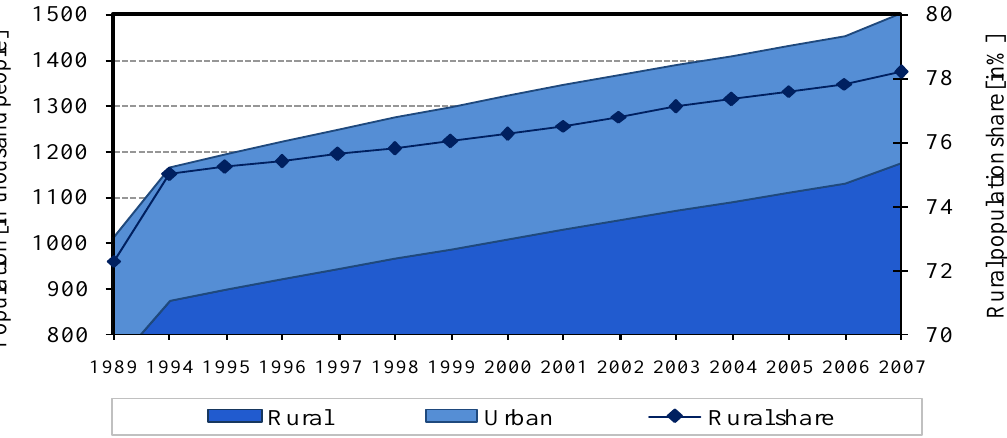
Figure 2. Population growth in the Khorezm region